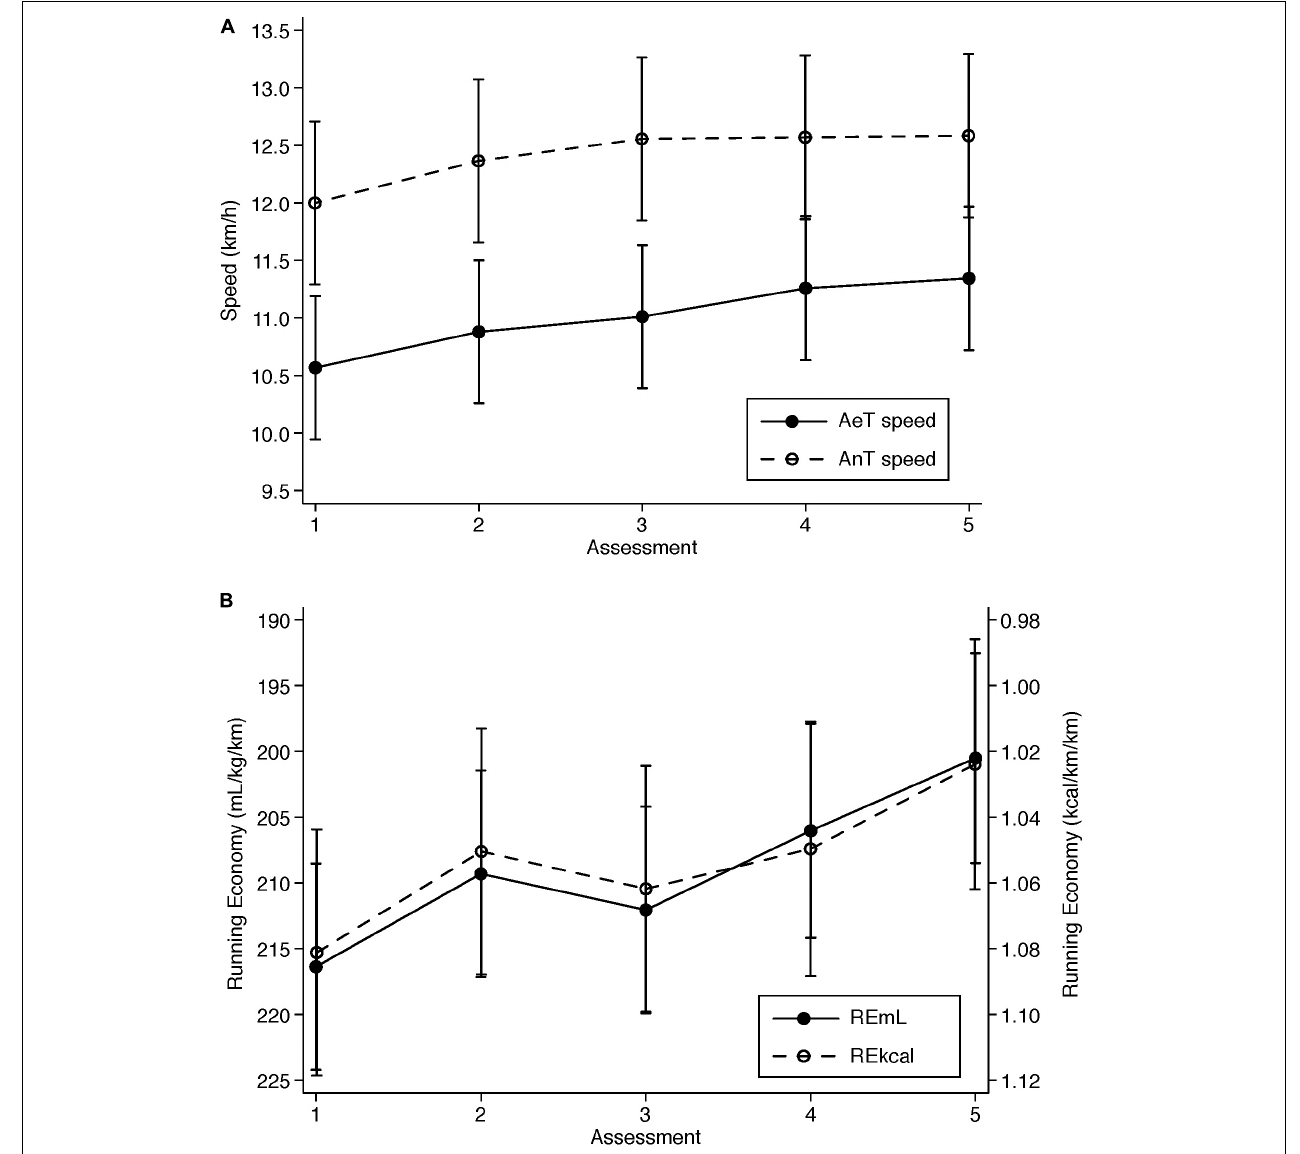
FIGURE 2 | Ventilatory thresholds speeds (A) and running economy (B) measured five times over 16 weeks. AeT speed: Aerobic threshold speed; AnT speed: Anaerobic threshold speed; REmL: running economy measured as oxygen cost, mL/kg/km; REmL: running economy measured as energy cost, kcal/kg/km. Assessments were performed at 116, 88, 60, 32, and 11 days prior to competing in the marathon. Data represent mean and 95% confidence intervals adjusted for participant’s random effects.